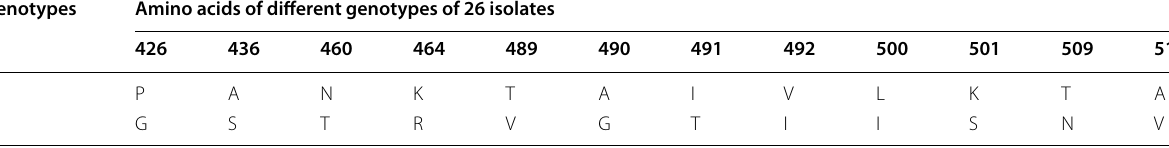
Table 4 Comparison of amino acids of capsid protein E region of 26 FCV isolates Genotypes Amino acids of different genotypes of 26 isolates